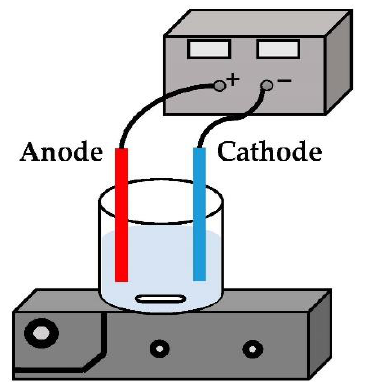
Figure 1. Schematic diagram of the electrochemical oxidation system.